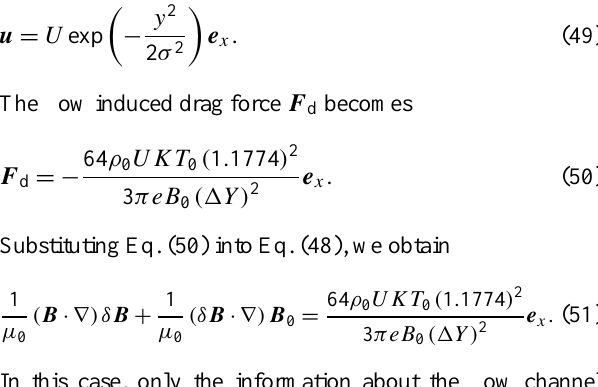
Fig. 8. Ratio of the x dimension to the y dimension of the cross- section area of fast flow.